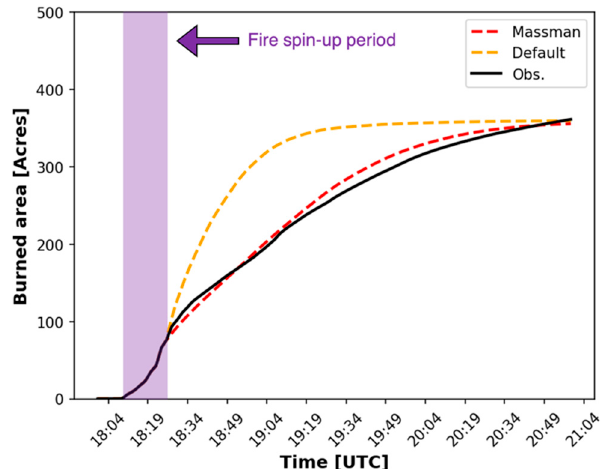
Figure 5. Time series of the fire burned area from infrared observations (black line), WRF-SFIRE simulations using the standard WAF assumption without a canopy wind model (orange-dashed line), and the WRF-SFIRE simulation using the ICM (red-dashed line).